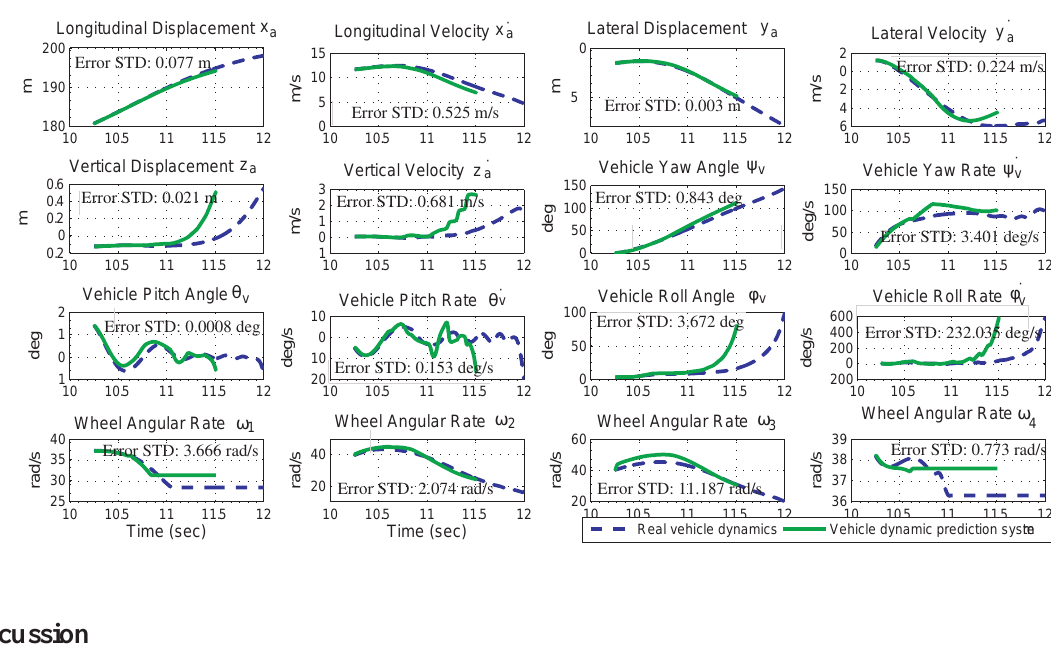
Figure 9. Predictions of the vehicle dynamics in a rollover event. The prediction system successfully predicts the rollover incident. The prediction inaccuracy is 27.3% on average, calculated from the 10.25th second to the 11.5th